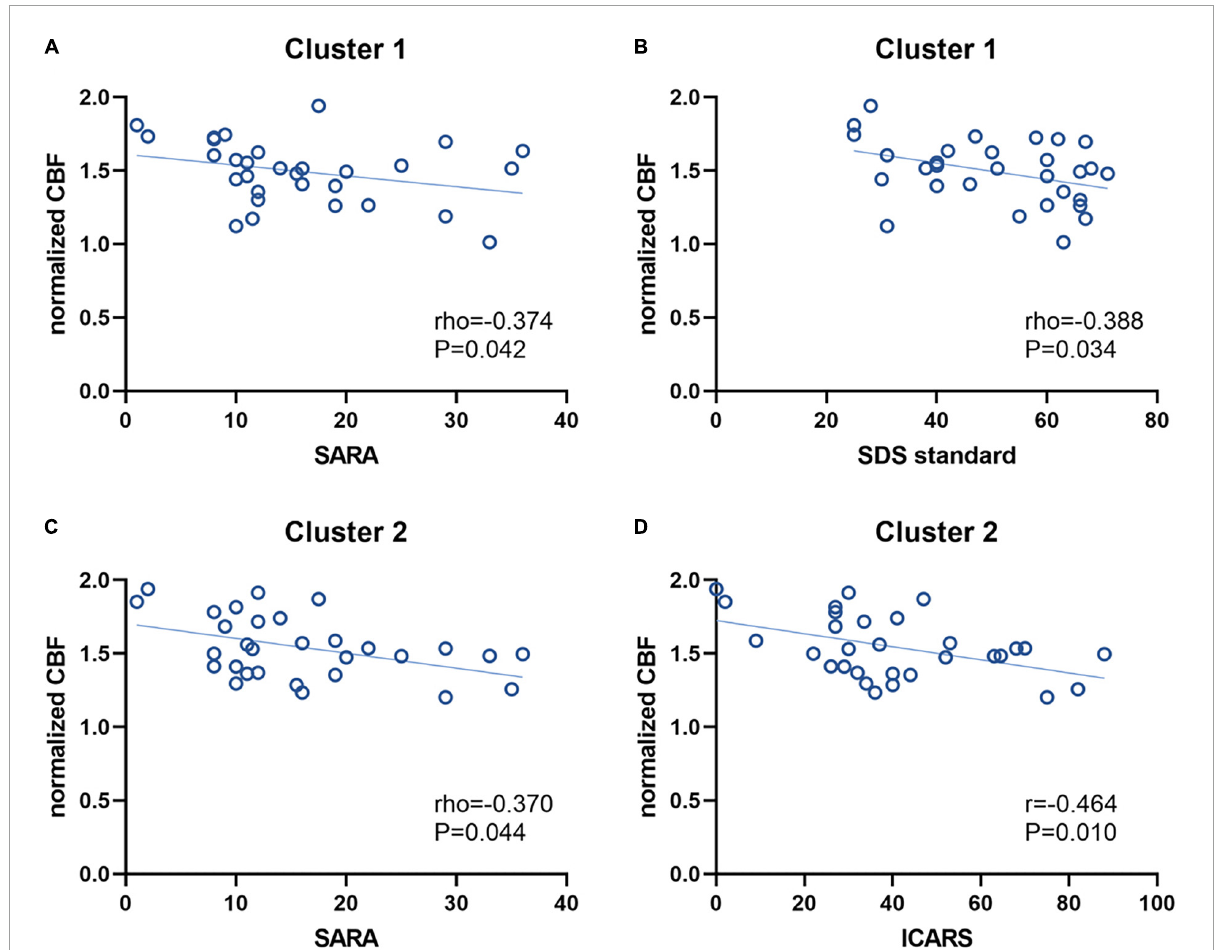
FIGURE4 Correlations between the normalized CBF values and clinical characteristics. The normalized CBF of Cluster 1 had a negative correlation with SARA scores (A) and SDS standard scores (B) , respectively. For Cluster 2, the normalized CBF was also negatively correlated with SARA scores (C) and ICARS scores (D) , respectively. CBF, cerebral blood flow; SARA, scale for assessment and rating of ataxia; SDS, self-rating depression scale; ICARS, international cooperative ataxia rating